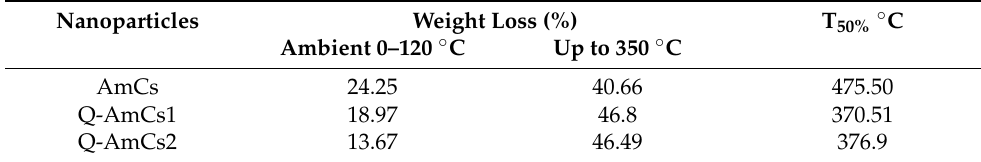
Table 1. TGA data for AmCs and Q-AmCs nanoparticles.